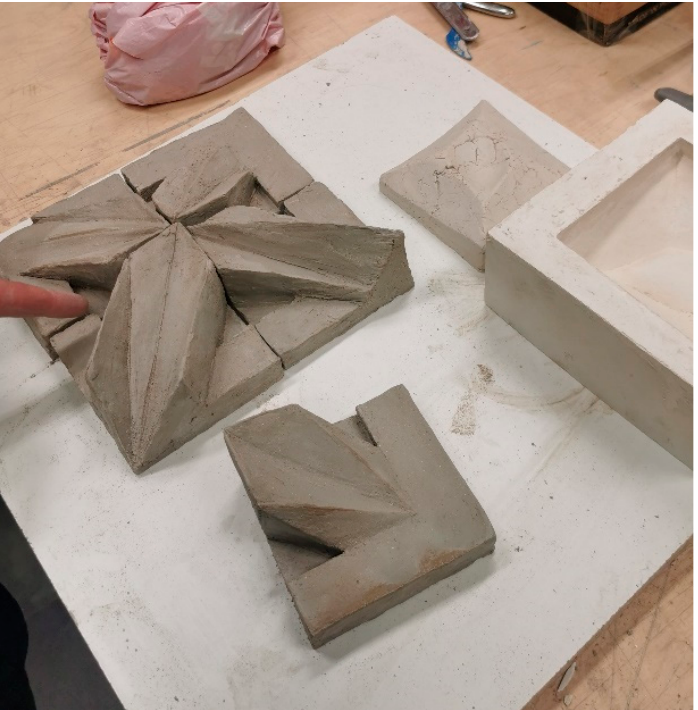
Figure 3. Wall cladding panels made of chamotte clay in realization (photo by K. G.-K.).